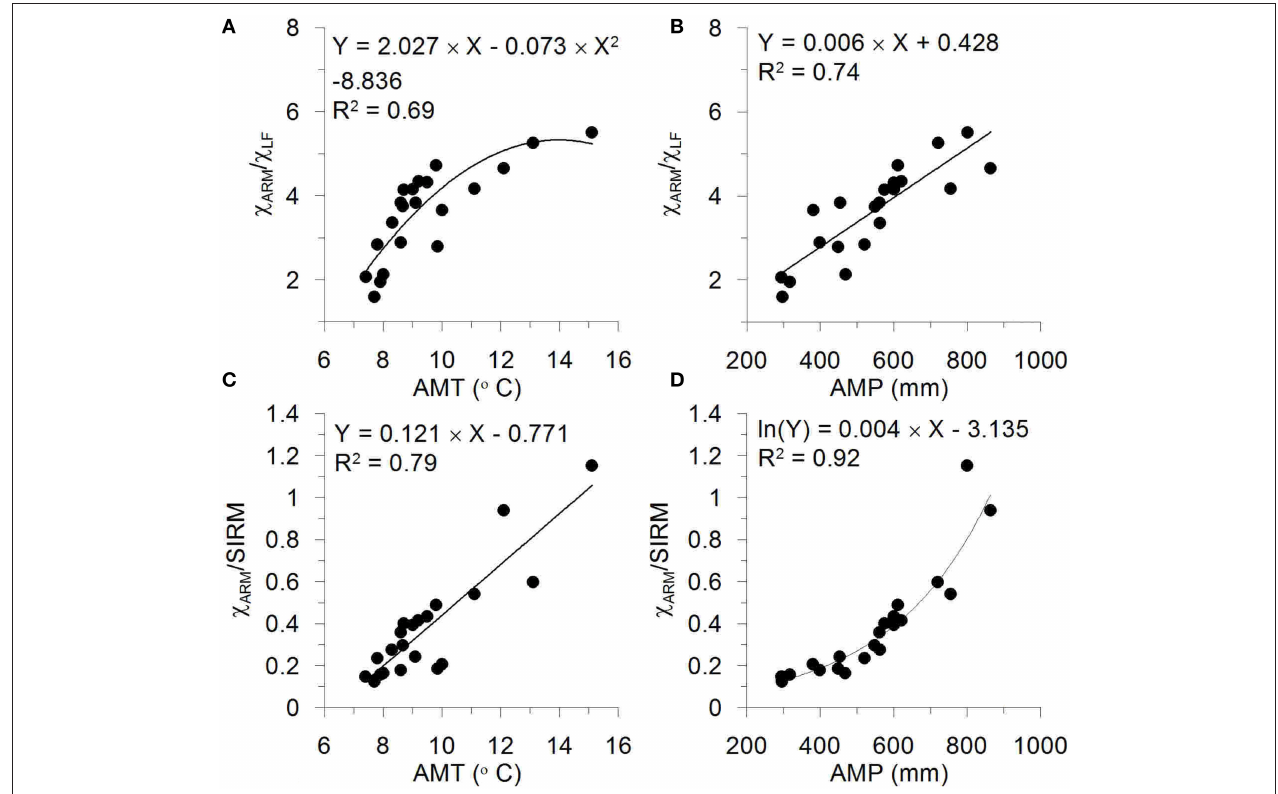
FIGURE 8 | Correlation patterns between Chinese Loess Plateau surface soil magnetic and climatic parameters. Modified from Nie et al. (2014b). (A) , χ ARM / χ LF and annual mean temperature (AMT); (B), χ ARM / χ LF and annual mean precipitation (AMP); (C) , χ ARM /SIRM and AMT; (D) , χ ARM /SIRM and